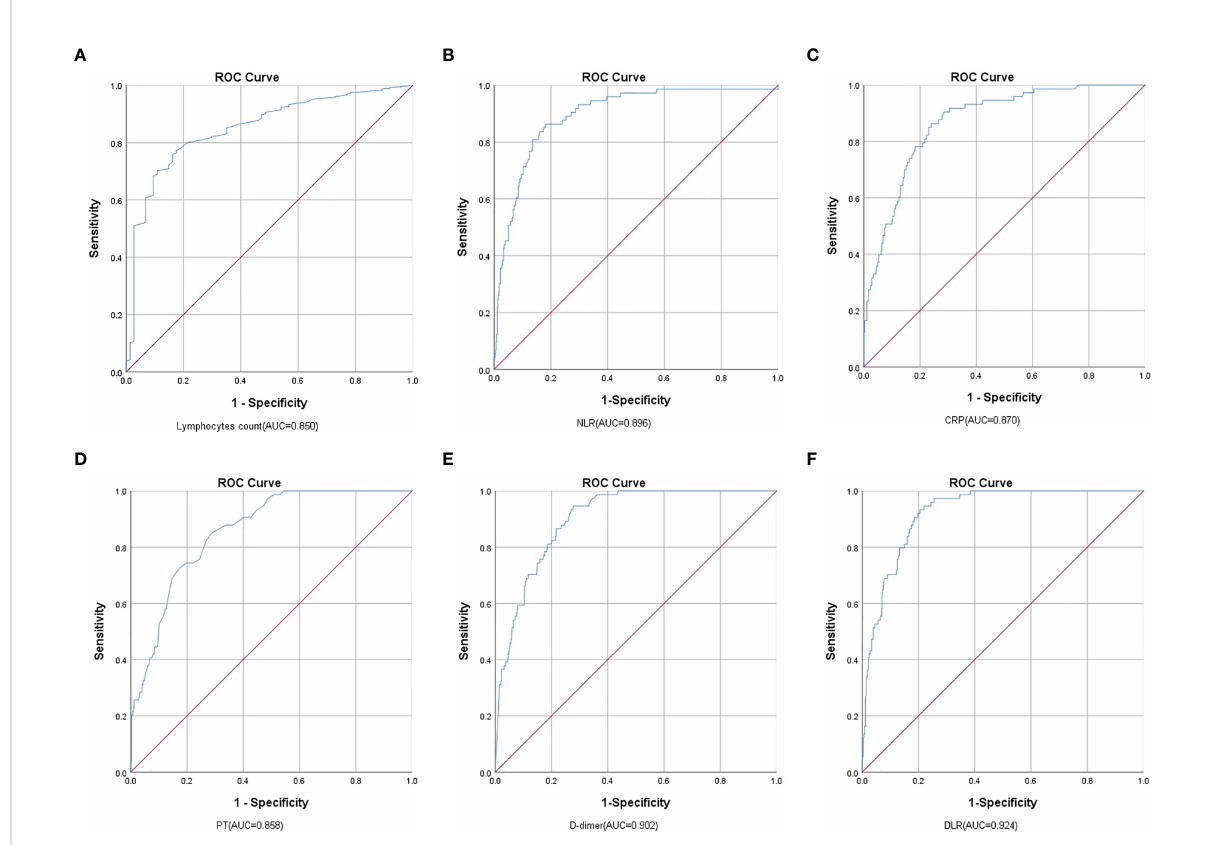
FIGURE 1 Analysis of the ROC curve of the (A) Lymphocytes, (B) NLR, (C) CRP, (D) PT, (E) D-dimer, and (F) DLR for the mortality of COVID-19. Comparing Lymphocyte, NLR, CRP, PT, D-dimer, and DLR, DLR had the highest AUC in predicting COVID-19